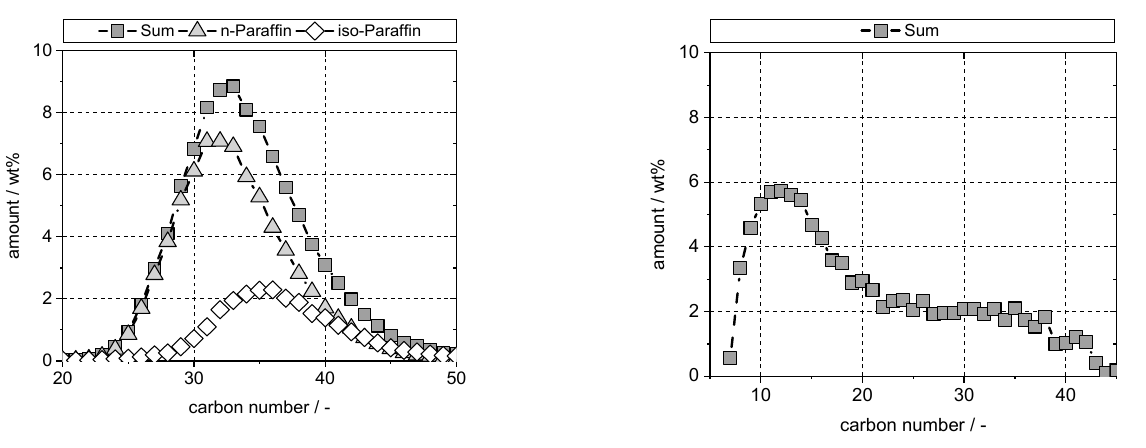
Figure 4. Chain length distribution of the Fischer–Tropsch wax ( left ) and pyrolysis wax ( right ) via simulated distillation.